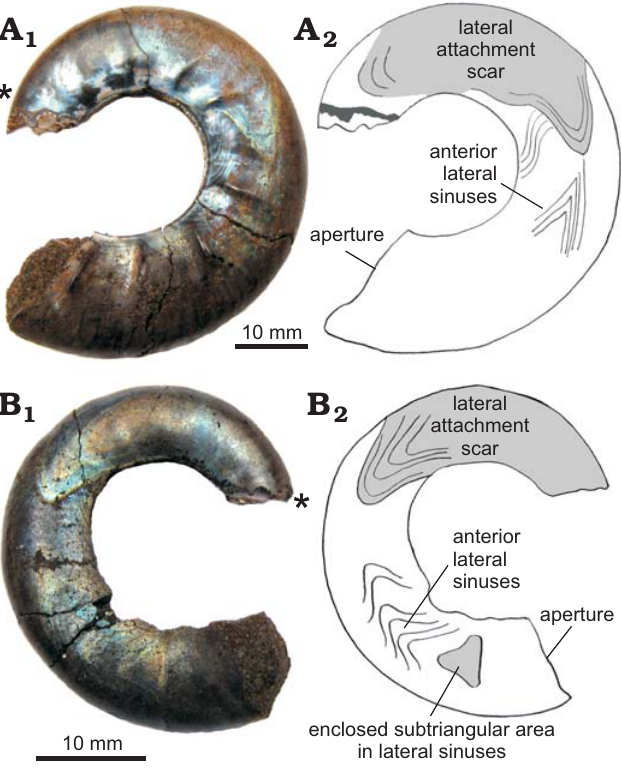
Fig. 6. Lateral attachment scars and lateral sinuses on Kachpurites fulgens (Trautschold, 1861) shells from Late Volgian ( Kachpurites fulgens Zone), Moscow region, Mnevniki locality (A), and Eganovo locality (B). A . MSU 113/1, fully preserved body chamber. Bright scars and lateral sinuses